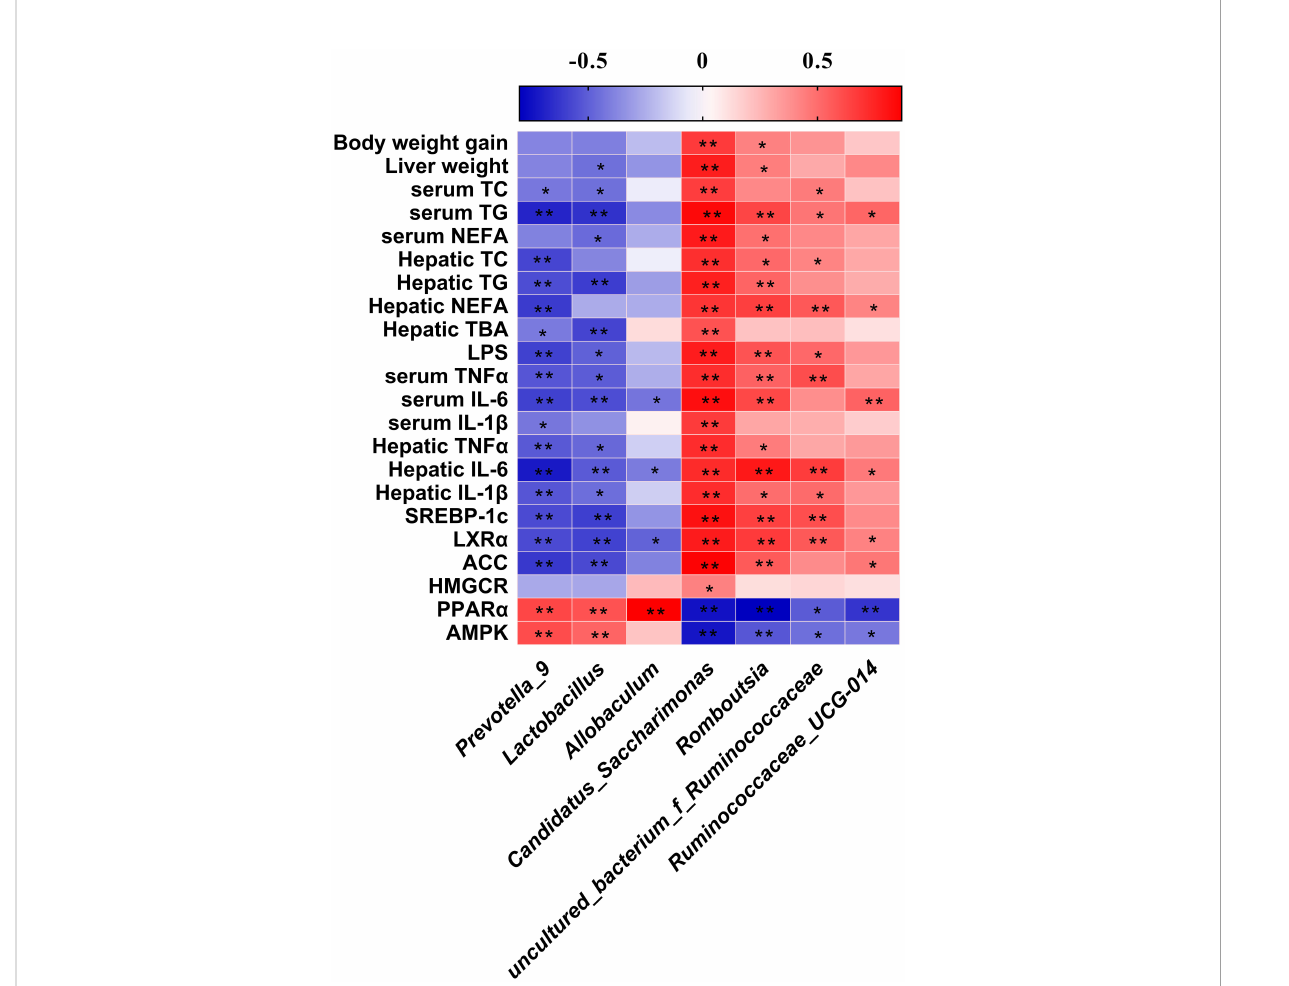
FIGURE 8 Heatmap of Spearman ’ s correlation between the gut microbiota and obesity-related indices. The intensity of the colors represented the degree of association (red, positive correlation; blue, negative correlation). Signi fi cant correlations are marked by *p < 0.05; **p < 0.01